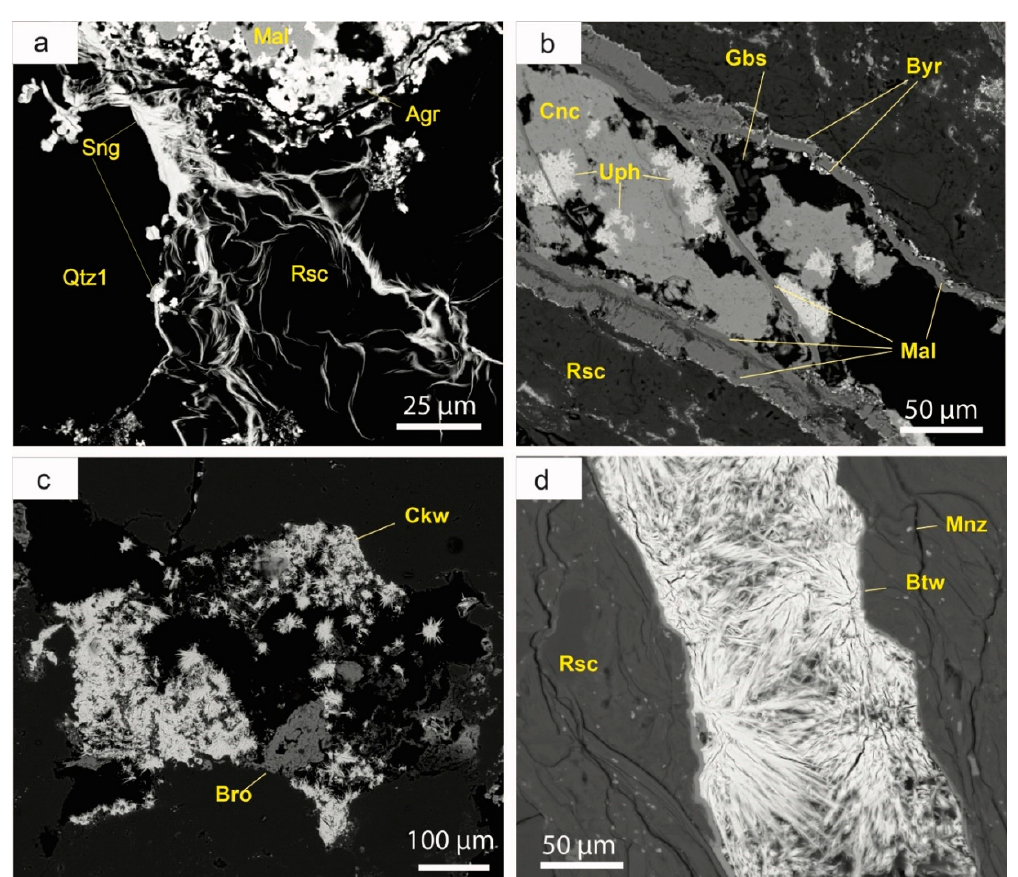
Figure 13. SEM-BSE images of late supergene uranyl carbonates and uranyil silicates. ( a ) Agricolaite (Agr) and malachite (Mal) as pseudomorphs after a sulphide grain. The roscoelite (Rsc) near detrital quartz (Qtz1) is replaced along cleavage by sengierite (Sng); ( b ) Sequence of vein infilling in roscoelite (Rsc) with malachite (Mal) followed by beyerite (Byr), then gibbsite (Gbs) and uranophane (Uph) followed by conichalcite (Cnc); ( c ) Radial aggregates of cuprosklodowskite needles (Ckw) pseudomorphing copper primary ores, together with brochantite (Bro); ( d ) Boltwoodite (Btw) in radial aggregates filling a veinlet in roscoelite (Rsc). Note the widespread occurrence of small monazite crystals (Mnz) scattered in roscoelite.